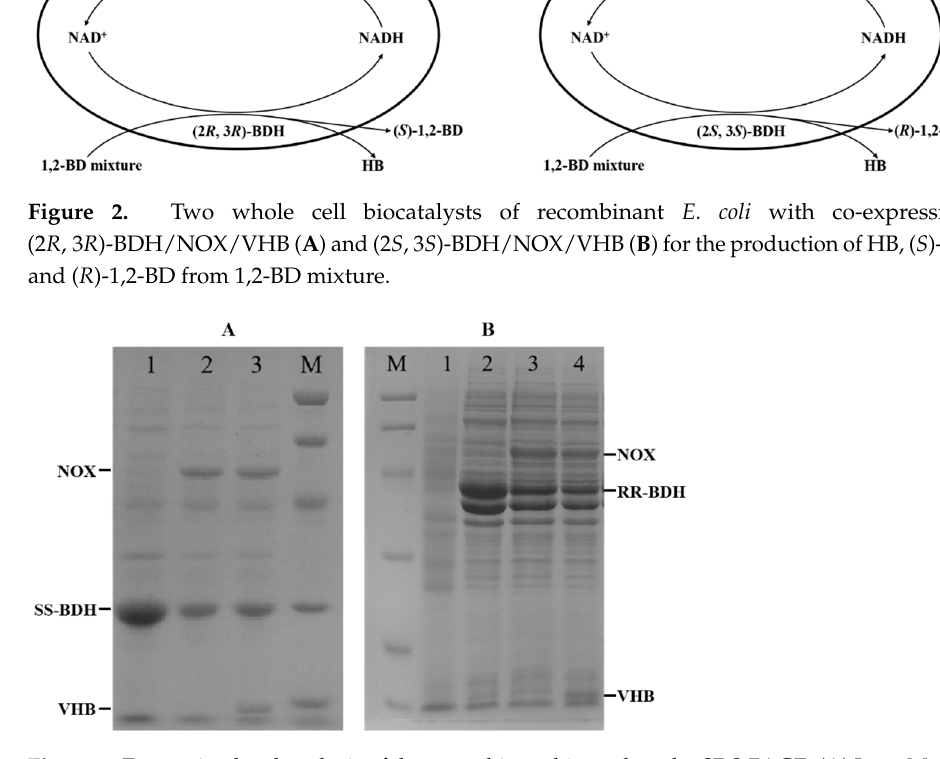
Figure 3. Expression level analysis of the recombinant biocatalysts by SDS-PAGE. ( A ) Lane M, marker (97.2, 66.4, 44.3, 29, 20.01, 14.3 kDa); Lane 1, E. coli (pET- ssbdh ); Lane 2, E. coli (pET- ssbdh - nox ); Lane 3, E. coli (pET- ssbdh - nox - vgb ); ( B ) Lane M, marker (97.2, 66.4, 44.3, 29, 20.01, 14.3 kDa); Lane 1, E. coli (pET28a); Lane 2, E. coli (pET- rrbdh ); Lane 3, E. coli (pET- rrbdh - nox ); Lane 4, E. coli (pET- rrbdh - nox - vgb ).